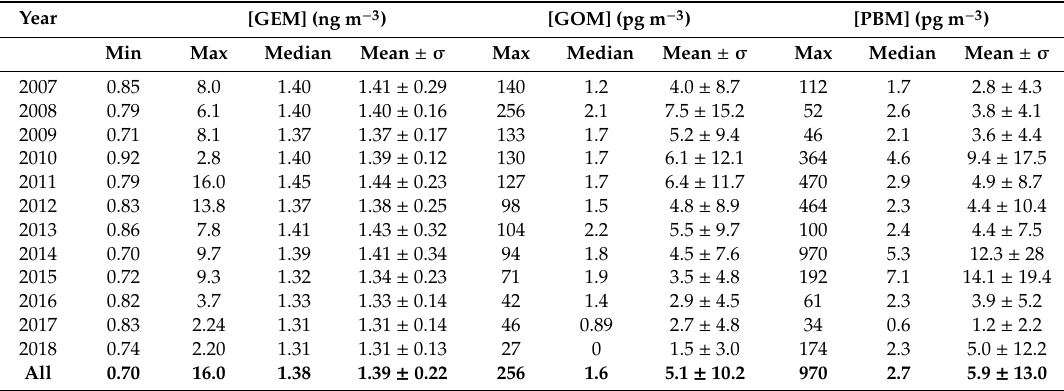
Table 1. Statistics of measured hourly concentrations of GEM, GOM, and PBM at the Grand Bay site in Mississippi. Minimum concentrations for GOM and PBM were zero (not shown). Overall statistics are shown in